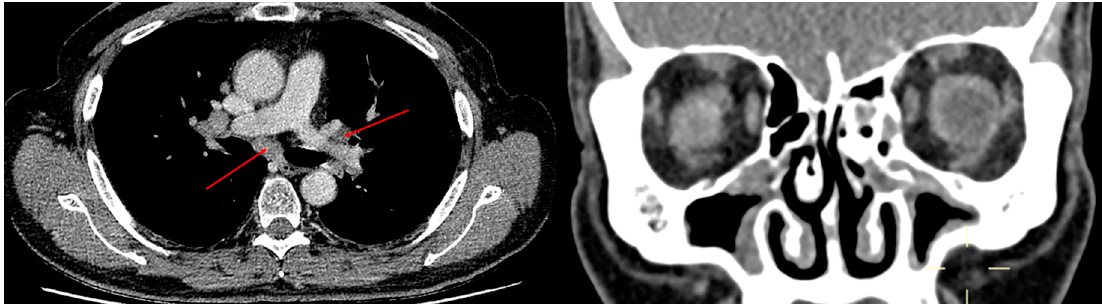
Figure 1. Transverse CT chest image with arrows indicating mediastinal and hilar lymphadenopathy. Coronal CT sinus image depicting disease affecting the ethmoid bullae and ostio-meatal complex.